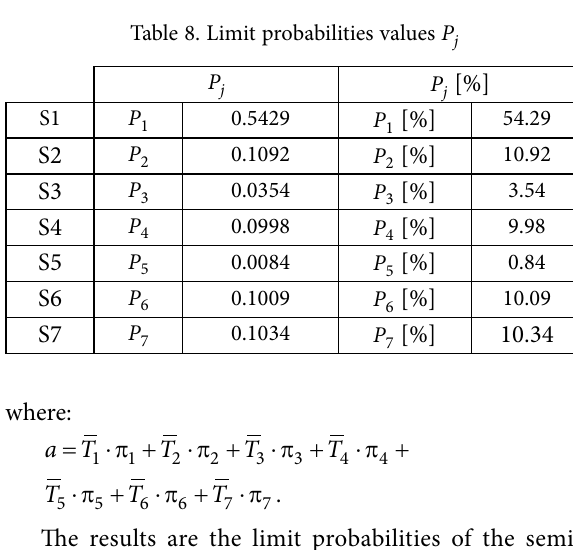
Table 6. Average conditional ij T [min] durations of the semi-Markov process states ij T